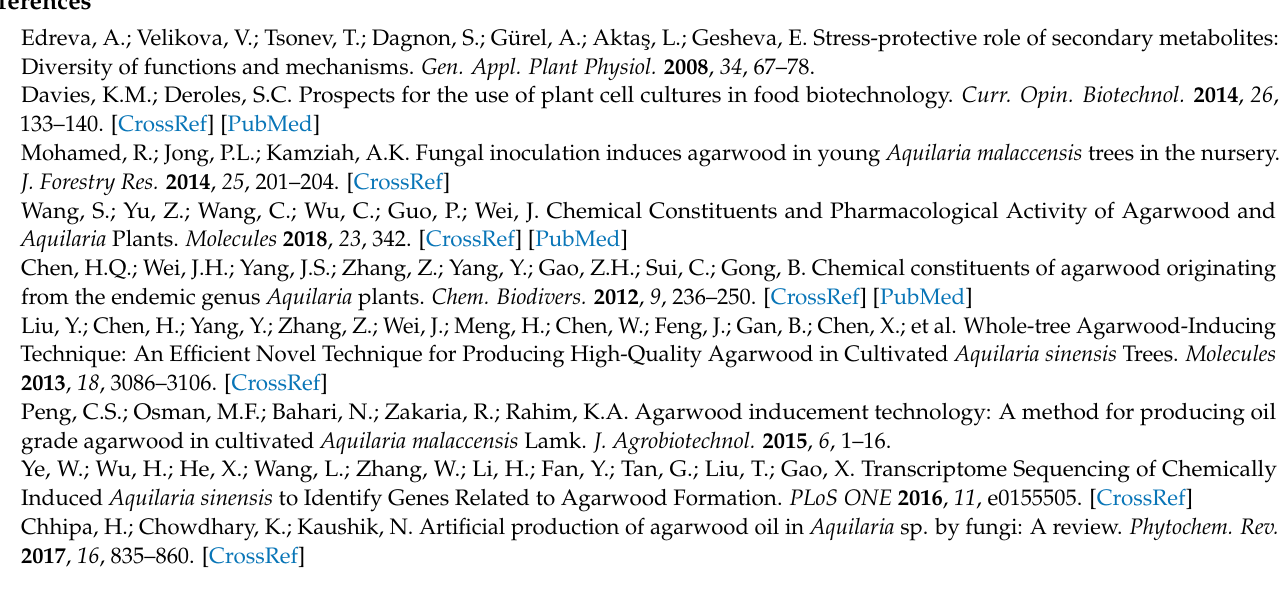
Table S7: qRT-PCR validation of selected genes obtained by RNA-seq in A. sinensis subjected to mechanical